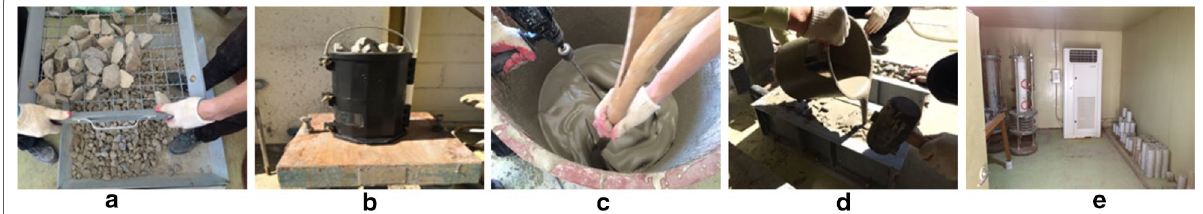
Fig. 9 Procedure for the fabrication of tested PAC specimens: a sieving, b packing aggregates in a mold, c mixing mortar, d filling the mold with mortar, and e